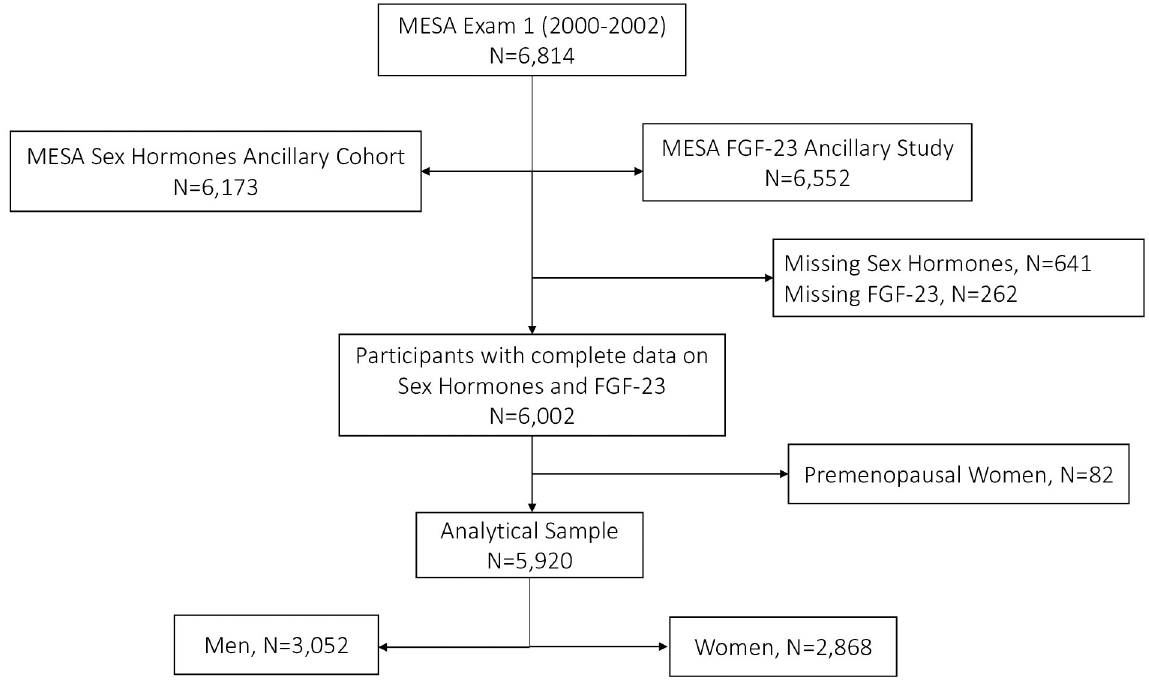
Fig 1. Flowchart of study